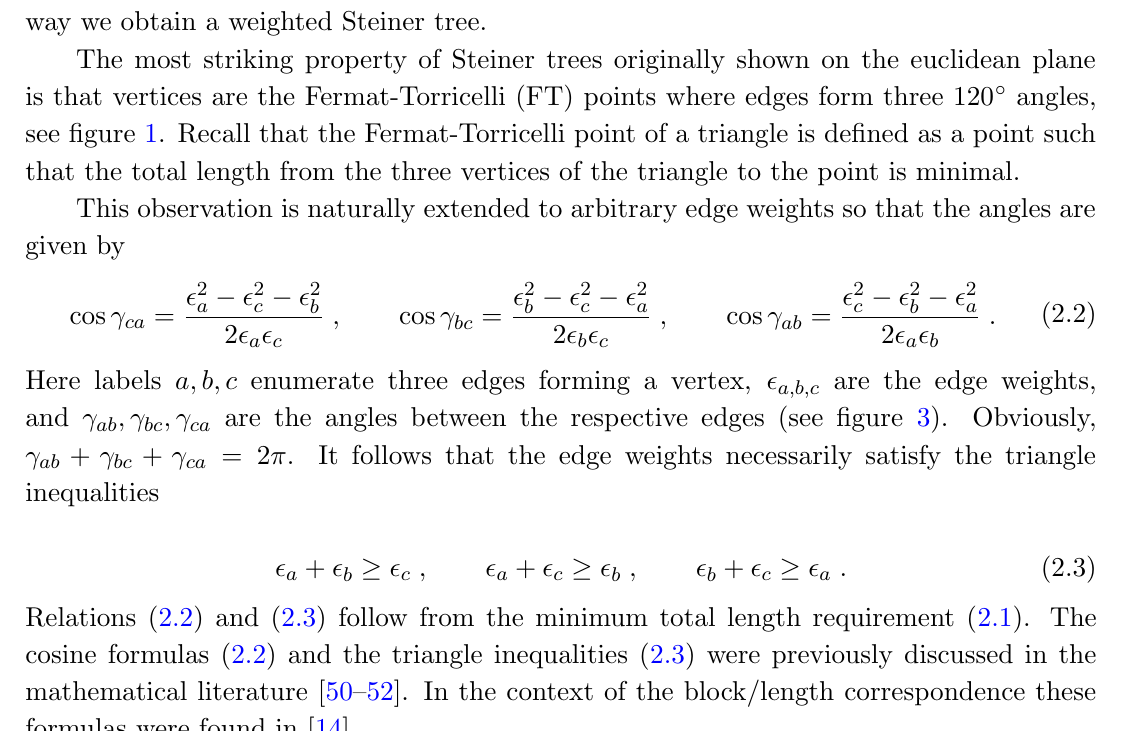
Figure 3 . Trivalent vertex (Fermat-Toricelli point) of a Steiner tree on the hyperbolic plane. All segments have di ↵ erent weights that is indicated by di ↵ erent colors.